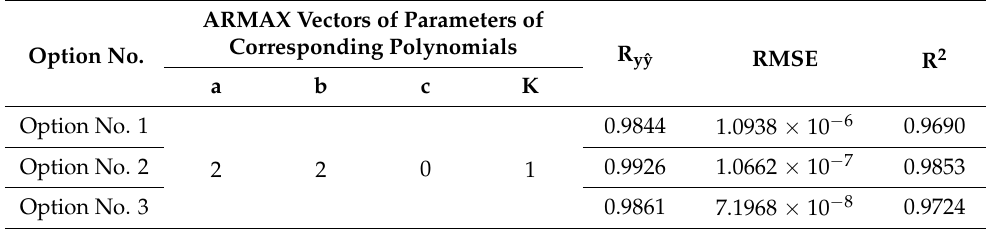
Table 3. R yˆy , RMSE, and R 2 coefficients of obtained SI algorithm using BJ and comparable generator.